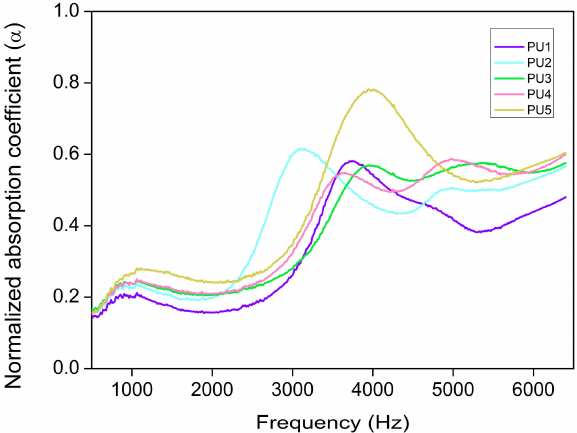
Figure 5. Acoustic absorption curves in the frequency range of 500–6500 Hz.